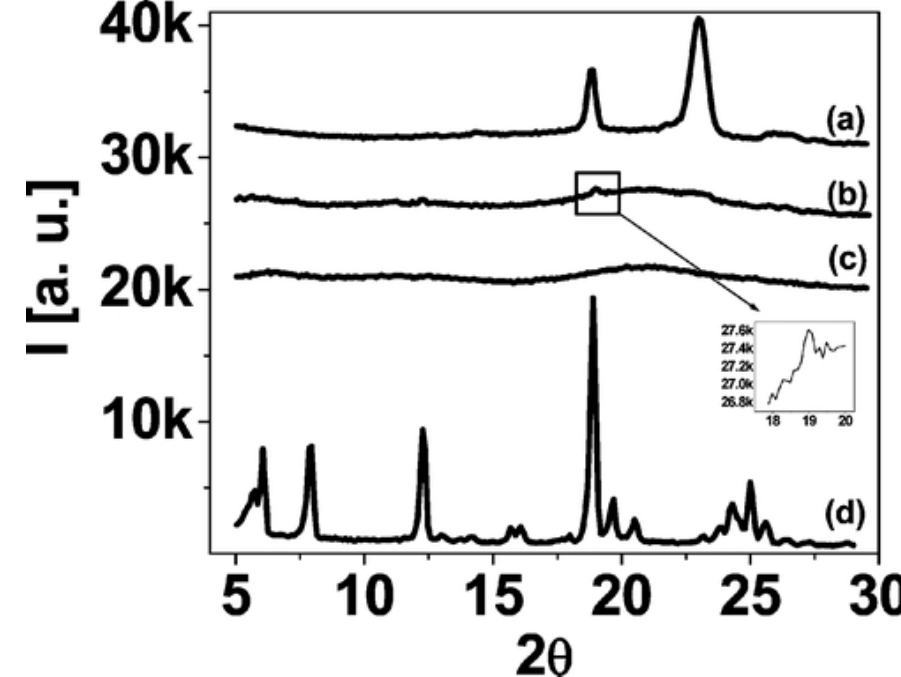
Figure 5. X-ray diffraction profiles of Pluronic F108 PEO-PPO-PEO block